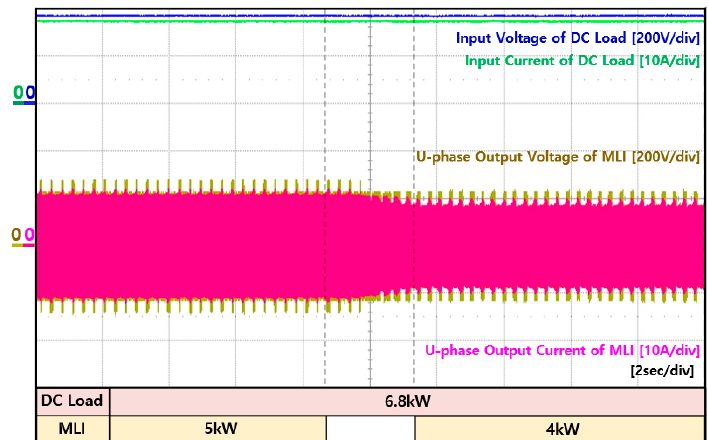
Figure 35. Experiment waveforms of DC load and multi-level inverter in mode 7.